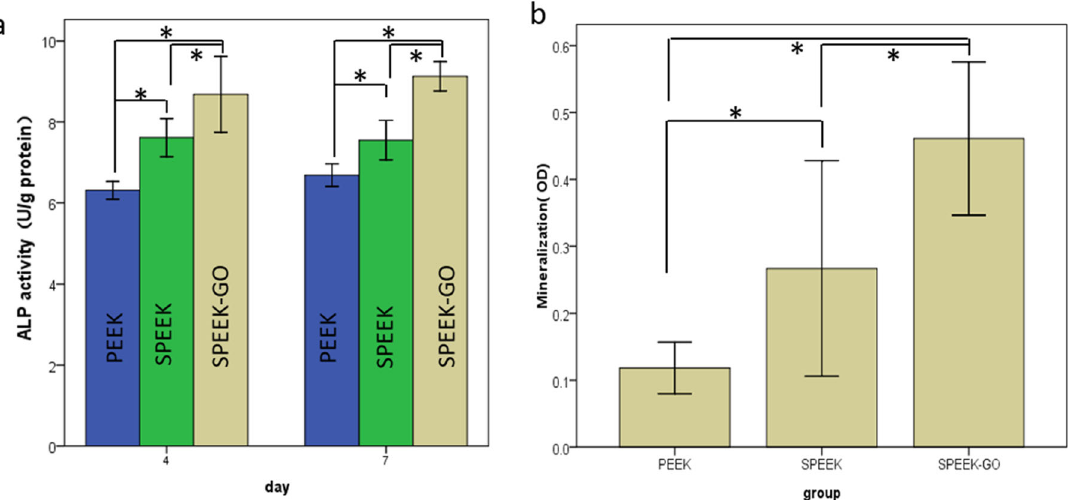
Fig. 13 a Alkaline phosphatase (ALP) activity quanti fi cation at days 4 and 7 of osteogenic induction in the cells. b Quanti fi cation of cell ECM mineralisation on the different surfaces at 14